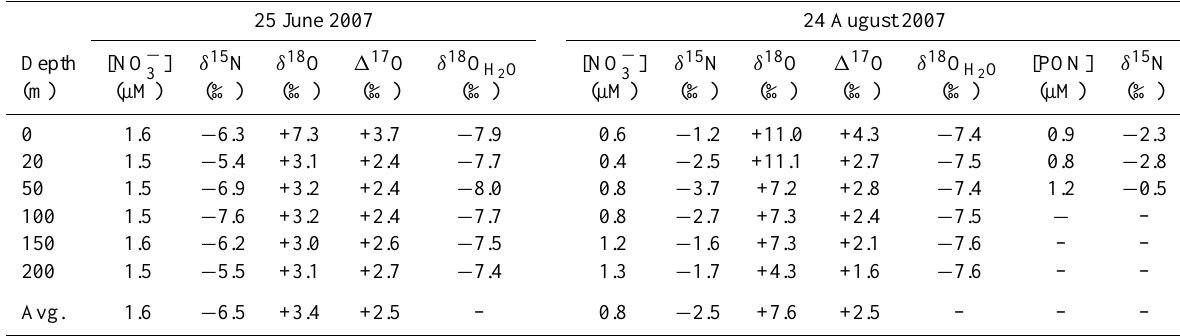
Table 1. Concentration and stable isotopic compositions ( δ 15 N, δ 18 O, and 1 17 O) of nitrate, δ 18 O of water, and concentration and δ 15 N of PON in lake water